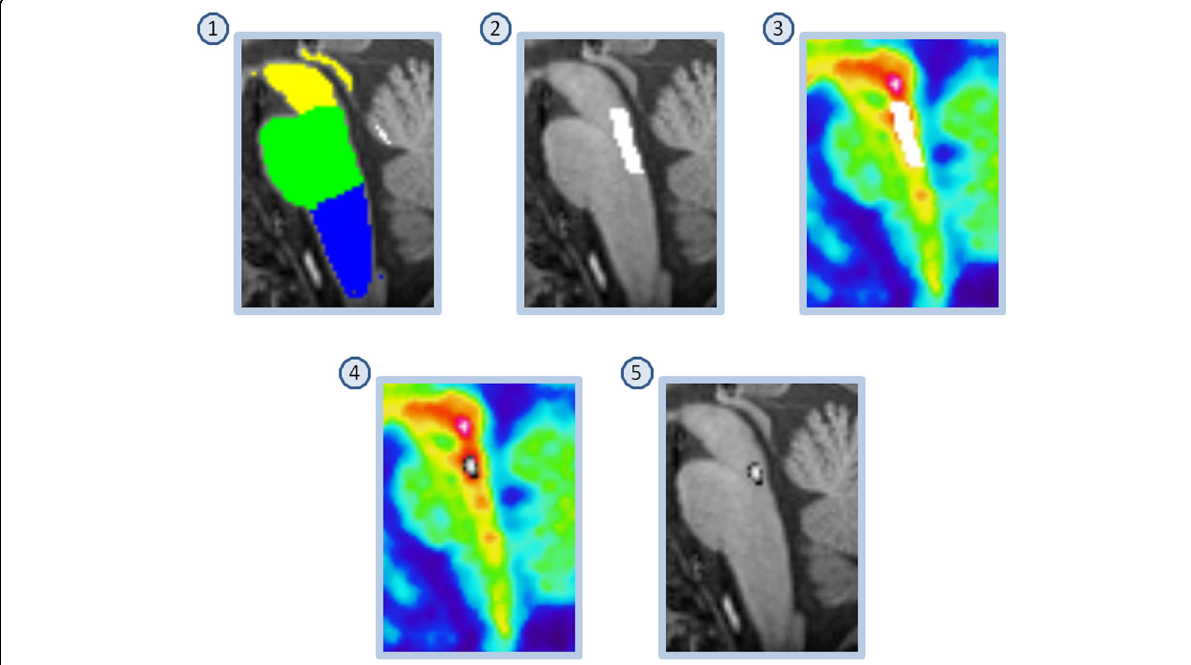
Fig. 2 Delineation of region preferentially sampling median raphe. (1) FreeSurfer Brainstem Substructures. (2) The pons mask (green) was trimmed, keeping the most dorsal 5 voxels. (3) The resulting mask was overlaid on the time-weighted summated PET-image. (4) Median raphe is the structure with highest [ 11 C]MADAM binding within the boundaries of the trimmed pons mask; the most intense PET-voxel was located and in an iterative process the voxel with highest intensity adjacent to the initial voxel was added until 65 voxels were collected. (5) The resulting mask overlaid on the MR-image. The same procedure was used to delineate a region preferentially sampling dorsal raphe except for using the midbrain mask (yellow in panel 1) and 116